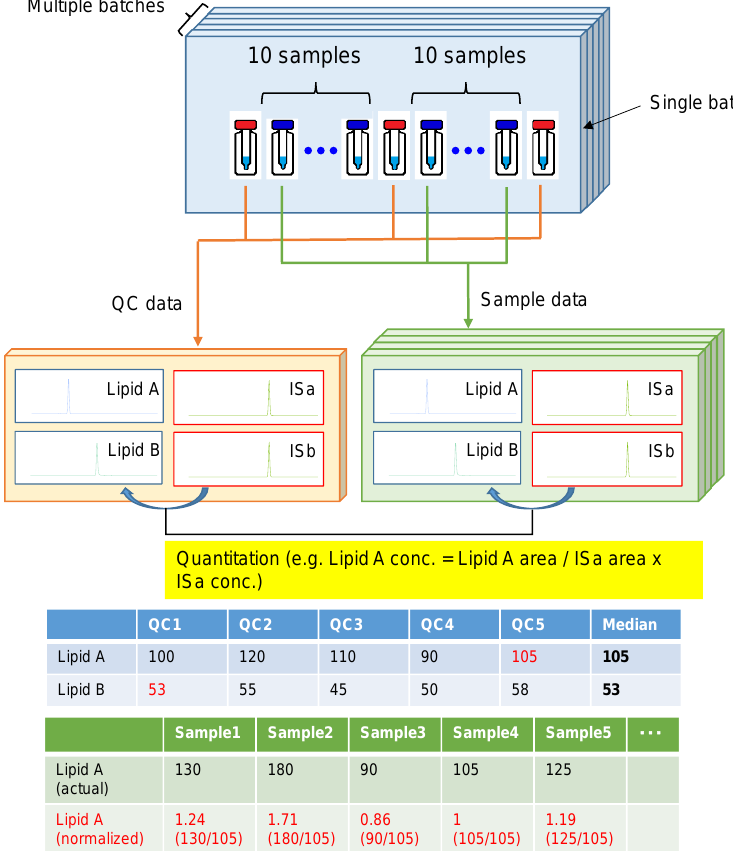
Figure 2. The quantitative and normalization method adopted in this study.